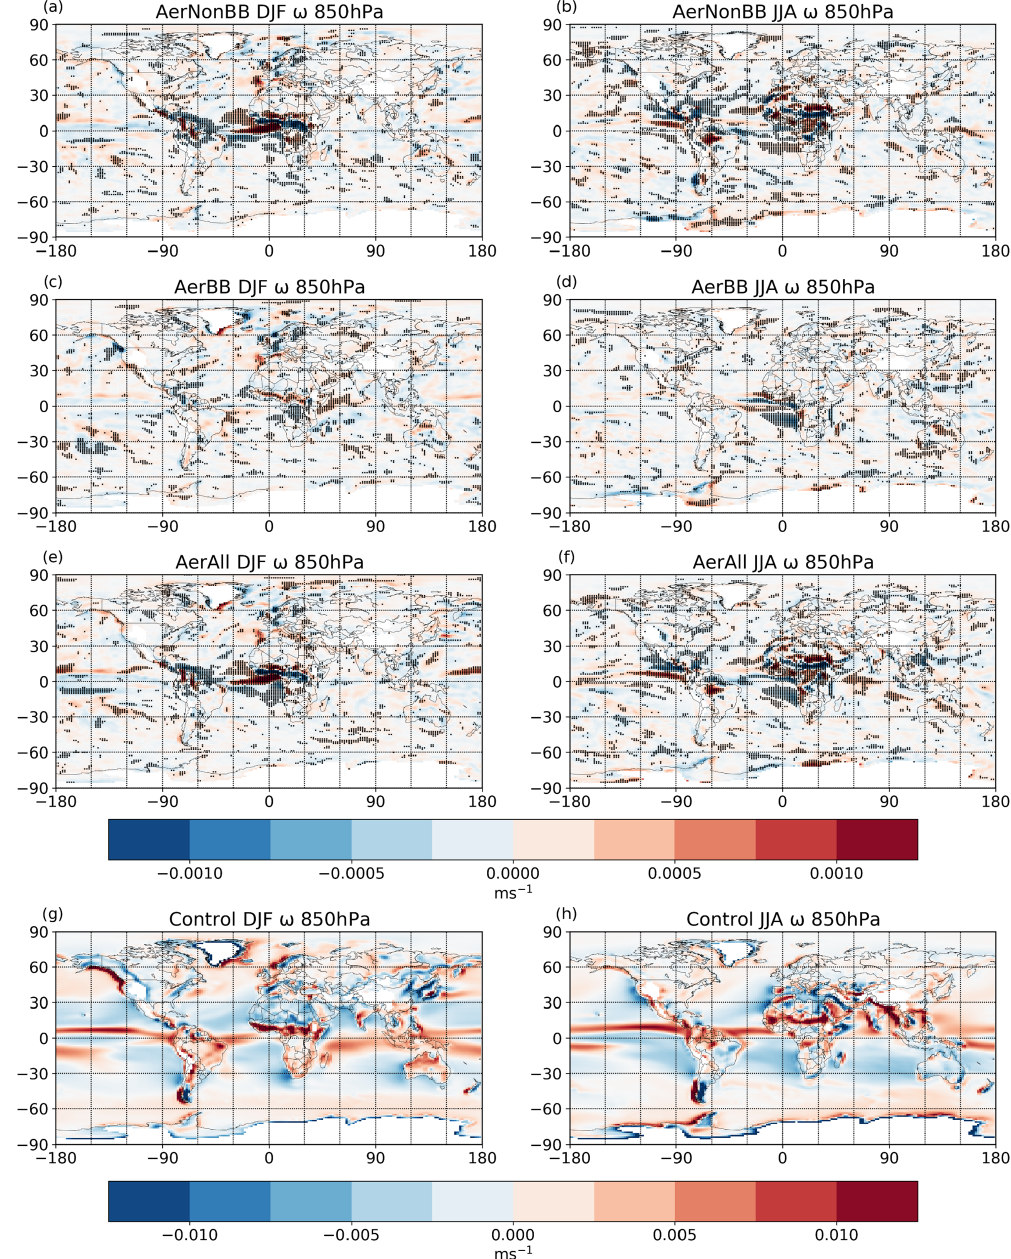
Figure 5. Vertical velocity changes at 850hPa in DJF and JJA for the three aerosol perturbations (AerBB, AerNonBB, and AerAll) relative to the control and for the period 2070–2100. The control background is also shown (g, h) . Stippling on panels (a) – (f) indicates grid cells where the change is significant with respect to intra-ensemble